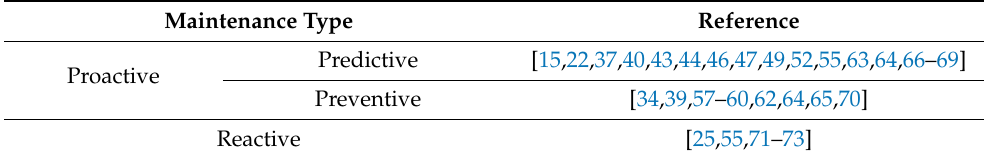
Table 5. Maintenance types in the